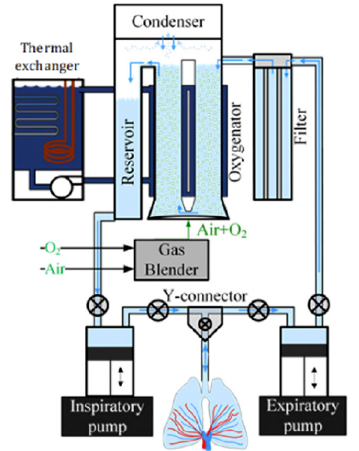
Figure 1. Schematic structure of a perfluorocarbon (PFC) liquid lung ventilator, requiring gas exchange of O 2 and CO 2 using condenser, ventilation of liquids to lung by separated pups for inspiration and expiration, and temperature control. Adapted with permission from Kohlhauer et al. [10].